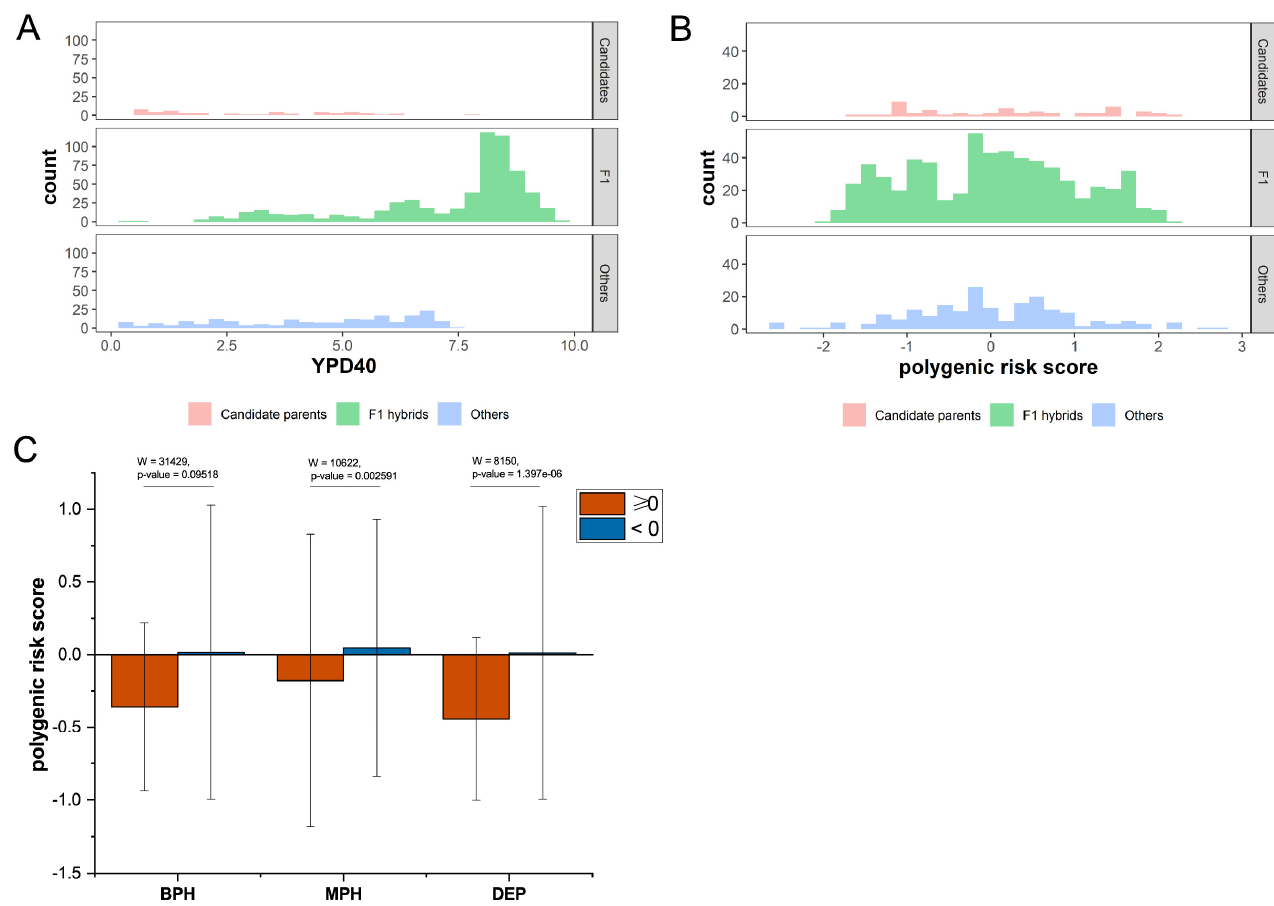
Figure 4. Distribution of YPD40 and PRS of F1 hybrids and 266 isolates for testing set. ( A ) Distribution of YPD40 of 52 parent strains and 613 F1 hybrids, as well as other strains in the testing set. The phenotype of F1 hybrids significantly exceeded that of parents and other strains, suggesting significant heterosis. ( B ) PRS distribution of 52 parent strains and 613 F1 strains, as well as other strains in the testing set. The parental strain and F1 strain had similar distribution range of PRS. ( C ) Relationship between heterosis of hybrid strains and PRS. BPH: best-parent heterosis, MPH: mid-parent heterosis, DEP: depression.